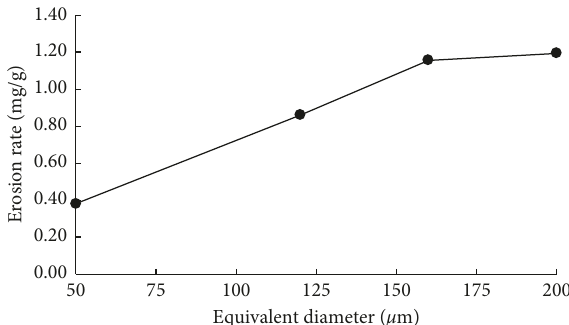
Figure 12: Change of the erosion rate with particle diameter.